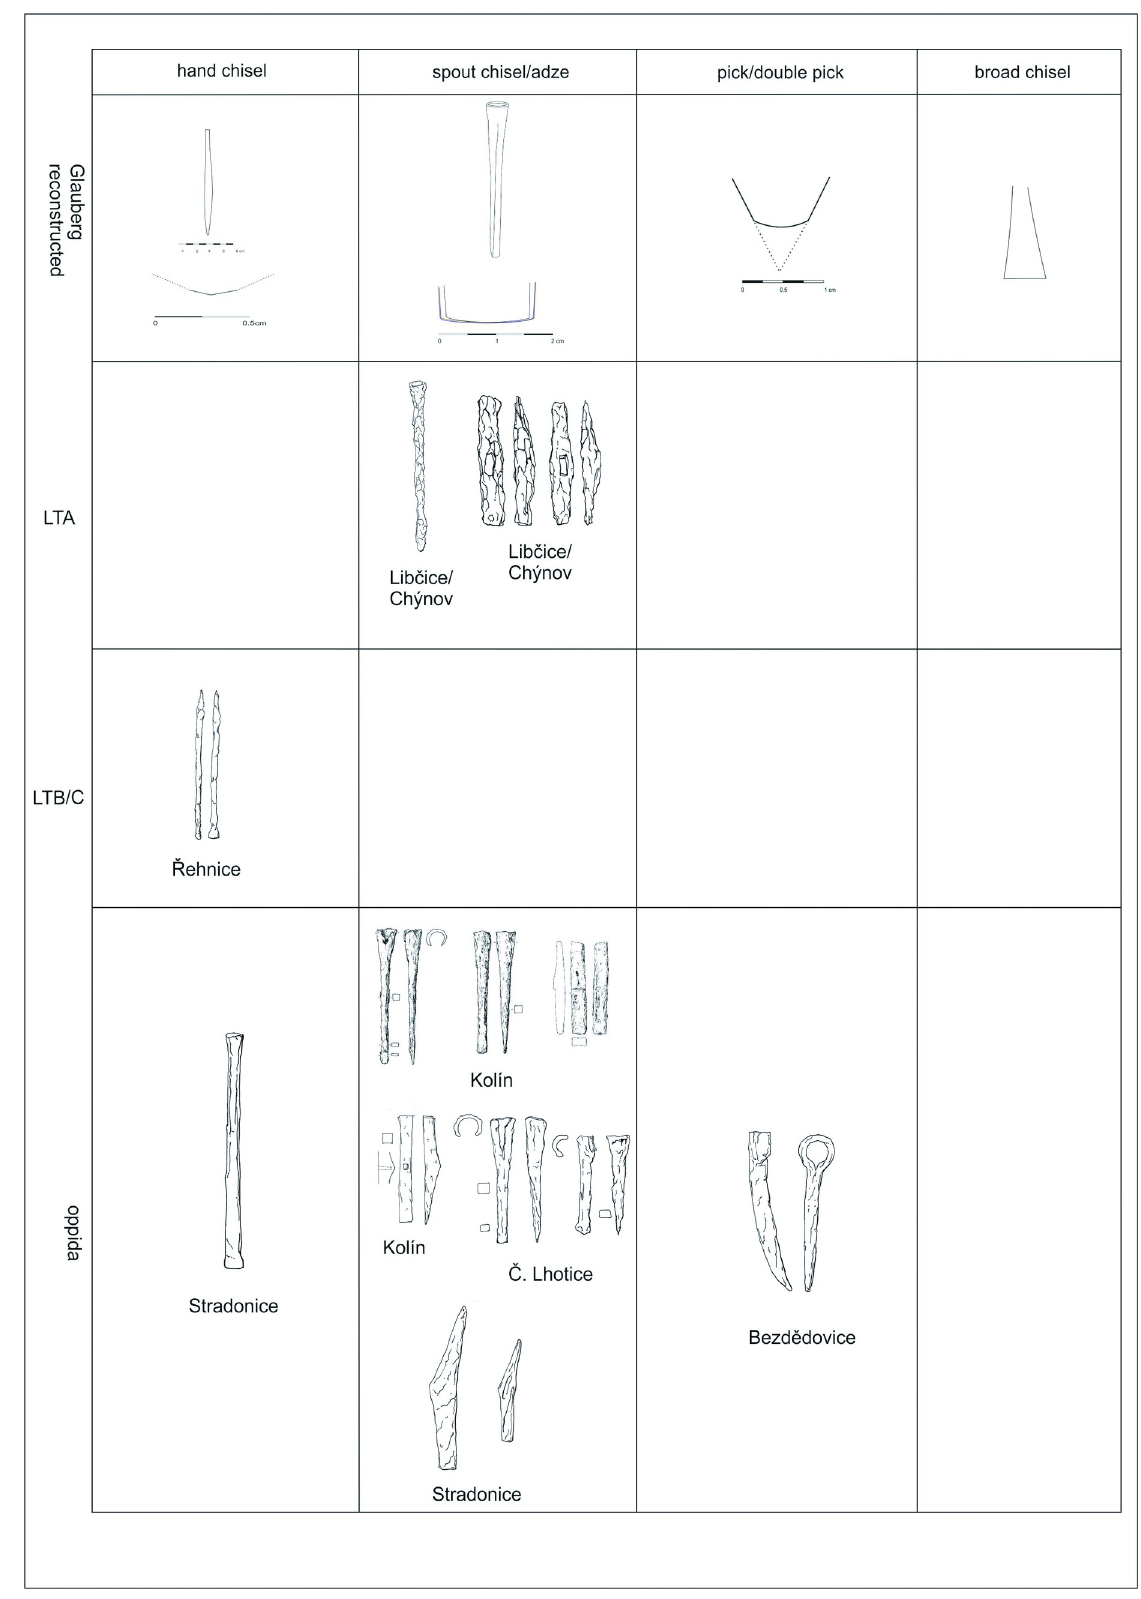
Fig 27. A comparative table of the reconstructed shapes of tools used during the sculpting of Glauberg fragments and the examples of tools from Bohemia (individual finds are not depicted in the same scale) (author: M. Trefny´ and A. Musilova´). https://doi.org/10.1371/journal.pone.0271353.g027 PLOS ONE | https://doi.org/10.1371/journal.pone.0271353 August 11,